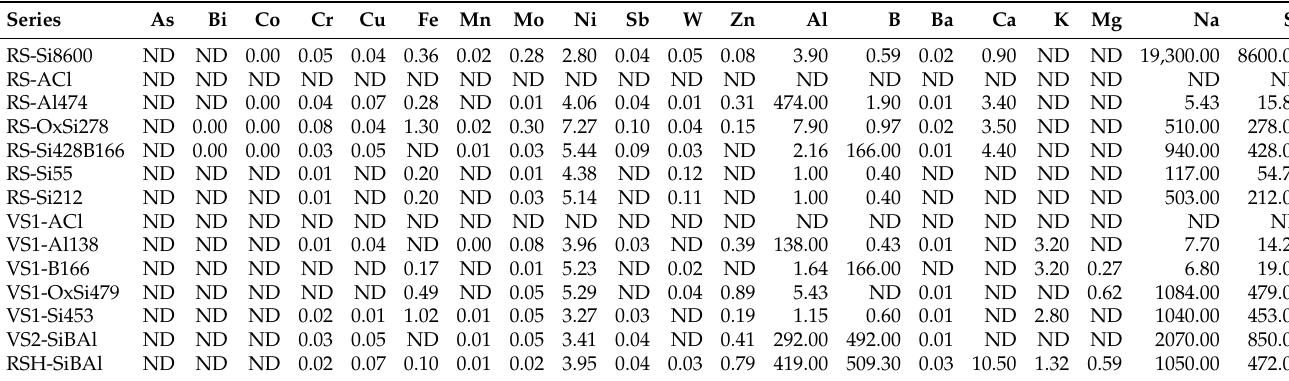
Table A1. Concentrations in µgL − 1 determined in spiked feed-waters.